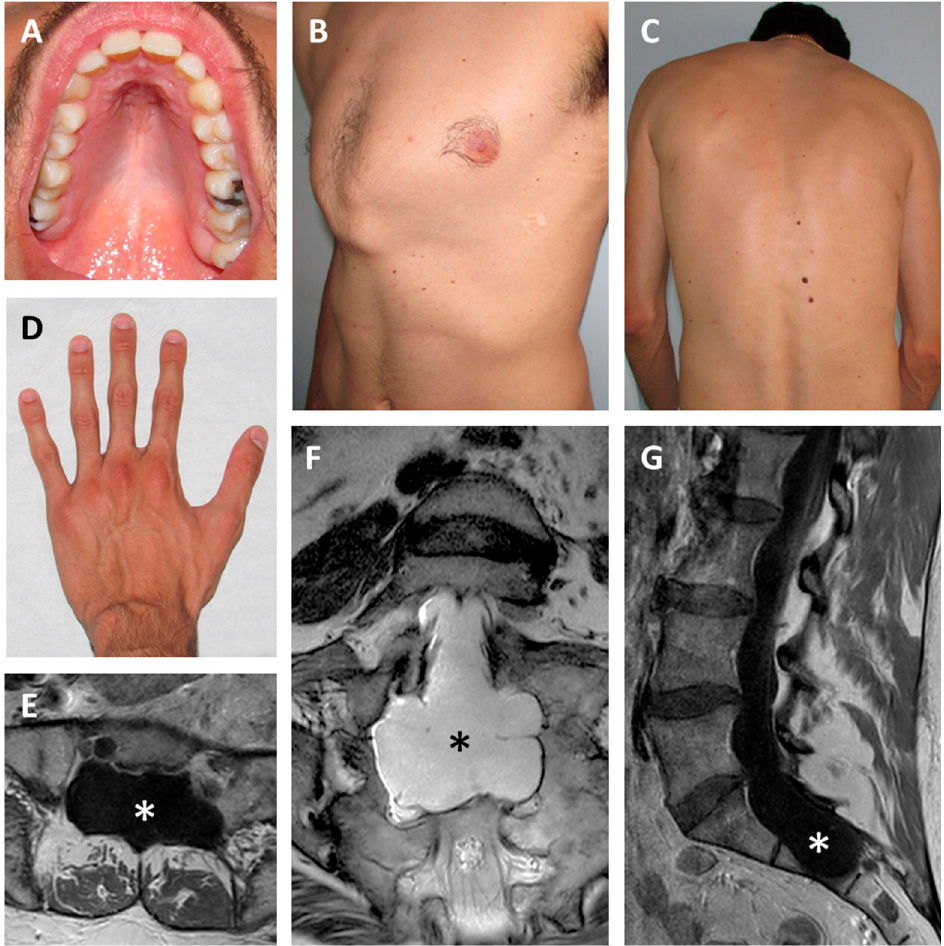
Figure 1. Clinical features. Individual 1 showing high-arched palate ( A ), pectus carinatum ( B ), scoliosis ( C ) and arachnodactyly ( D ). Lumbar spine MRI of Individual 2 demonstrating bilateral dural ectasias at axial ( E ), coronal ( F ), and sagittal ( G ) views. Asterisks indicate the dilated dural sac.